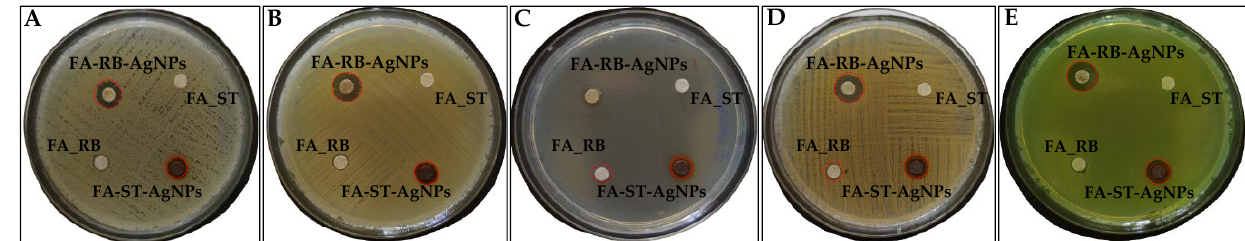
Figure 7. Disk diffusion tests for silver nanoparticles obtained using both synthetic and rye bran- derived trans -ferulic acid against Bacillus subtilis ATCC6633 ( A ), Escherichia coli ATCC25922 ( B ), Enterococcus faecium ATCC29212 ( C ), Staphylococcus aureus ATCC65388/NCTC7447 ( D ), and Pseudomonas aeruginosa ATCC10145 ( E ). The zone of inhibition is highlighted with a dashed red circle indicating a noticeable antibacterial effect. FA-ST-AgNPs — silver nanoparticles produced by synthetic trans -ferulic acid; FA-RB — a mixture of trans -ferulic acid and trans - iso -ferulic acids recovered from rye bran after enzymatic hydrolysis with multi-enzyme complex Viscozyme L; FA-RB-AgNPs — sil- ver nanoparticles produced by biosynthetic trans -ferulic and trans - iso -ferulic recovered from rye bran after enzymatic hydrolysis with multi-enzyme complex Viscozyme L; FA-ST — synthetic trans -ferulic acid.